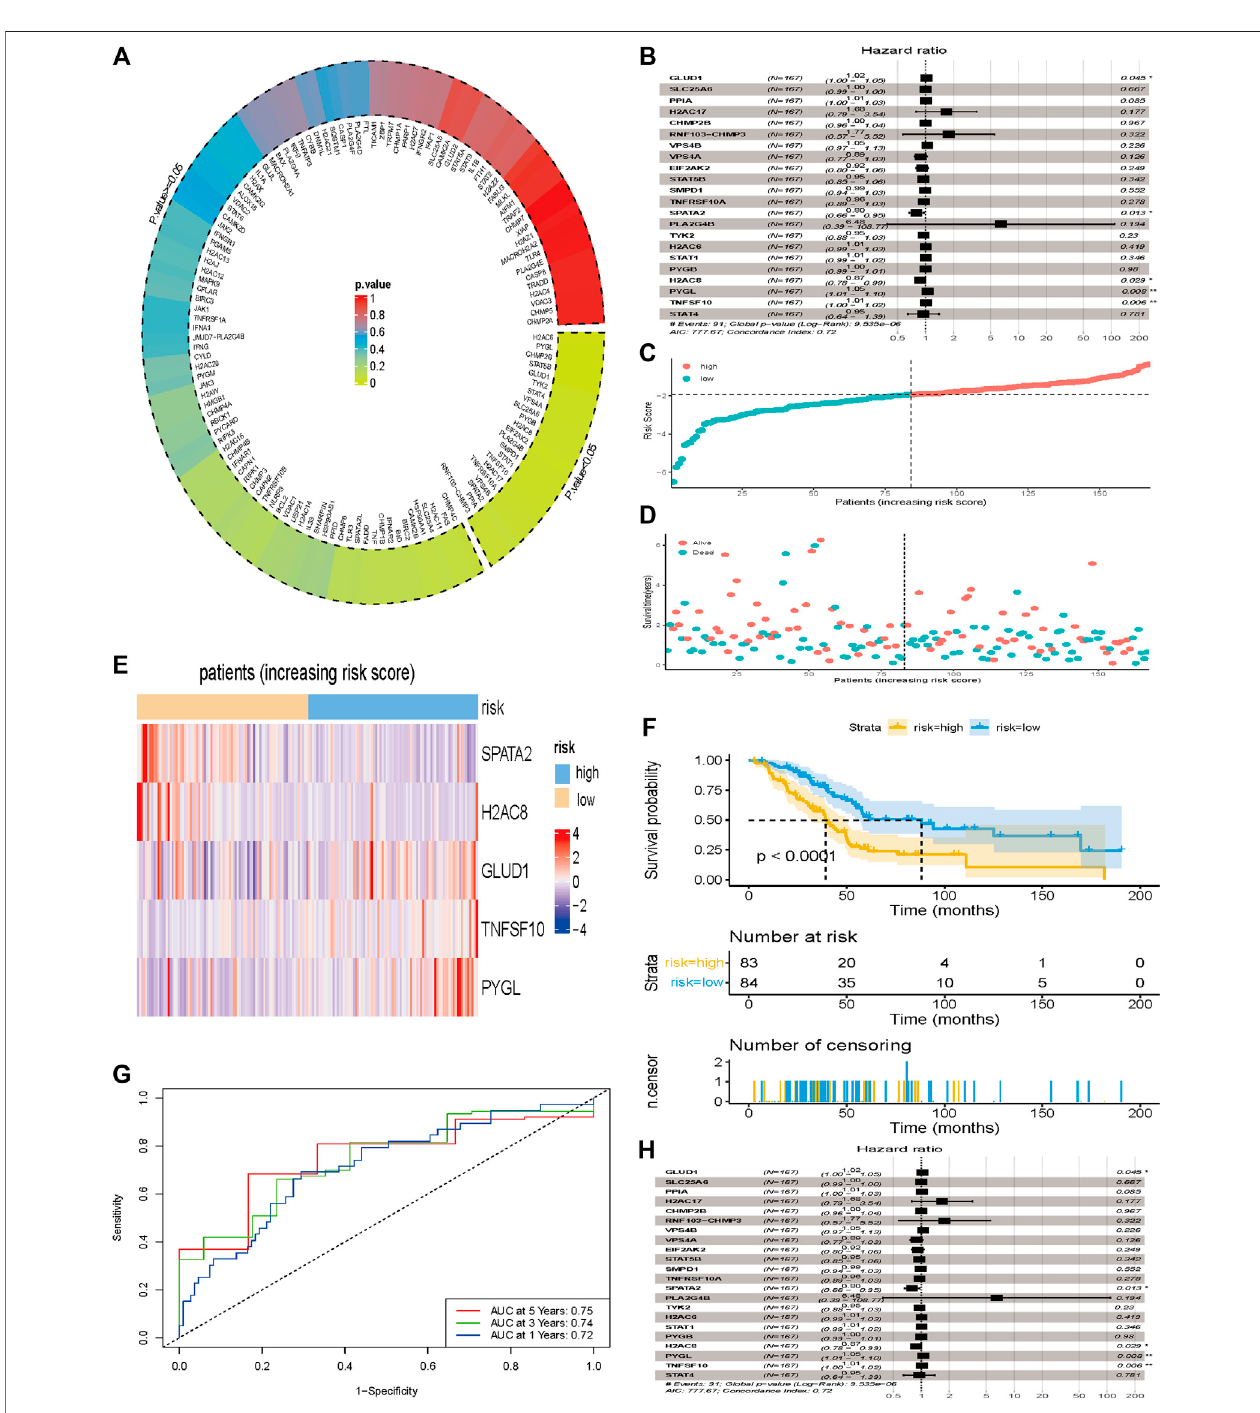
FIGURE4| Developmentofaprognosticindexbasedontheidenti fi edNRGs. (A) 132differentiallyexpressedNRGswereincludedintheunivariateCoxregression analysis and results showed that 22 NRGs at the bottom right of the plot circled by dotted line were correlated with overall survival ( p < 0.05). (B) 22 NRGs screened by univariate Cox regression analysis were included in the multivariate Cox regression analysis and results showed that 5 NGRs (GLUD1, SPATA2, H2AC8, PYGL, and TNFSF10)wereindependentfactorsforprognosisofPCa. (C) Thenumberofpatientsindifferentriskgroups. (D) Survivalstatusofpatientsacrossdifferentgroups. (E) Heatmap showing the expression pro fi le of the 5 DRGs. (F) Kaplan-Meier curves of overall survival of patients in the high- and low-risk groups, strati fi ed by the necroptosis-related signature in the cohorts. (G) A forest plot of multivariate Cox regression analysis in the cohorts . (H) ROC curves of overall survival for the NRG signature. The AUC values for 1-, 3- and 5- years in the TCGA cohorts were 0.72, 0.74 and 0.75, respectively.